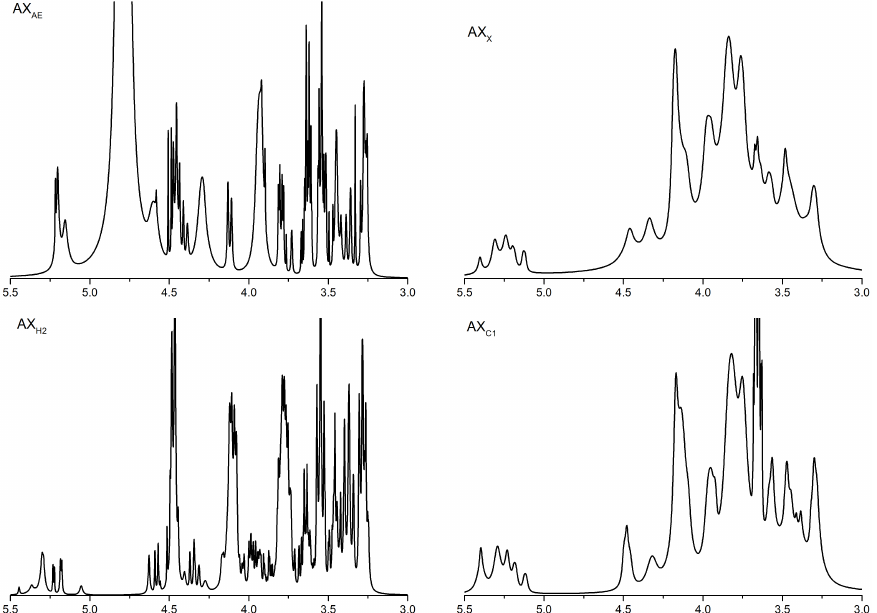
Figure 1. 1 H NMR analysis of AXH. AX AE , triticale bran arabinoxylan was treated with α -L- arabinofuranosidase; AX C1 , triticale bran arabinoxylan was treated with 0.1 M citric acid; AX H2 , triticale bran arabinoxylan was treated with 0.15 M HCL; AX X , triticale bran arabinoxylan was treated with endo-1,4- β -xylanase.